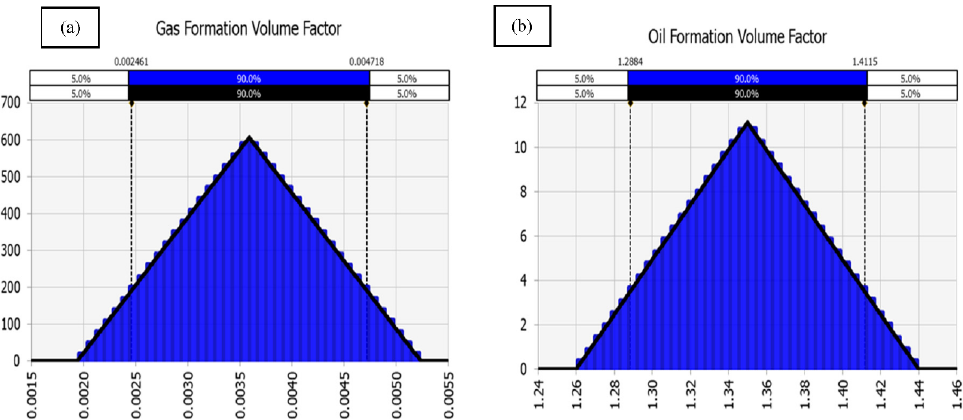
Figure 8. Distributions of ( a ) water–oil ratios (WOR) and ( b ) gas–oil ratios (GOR). Table 4. Triangular distribution parameters.